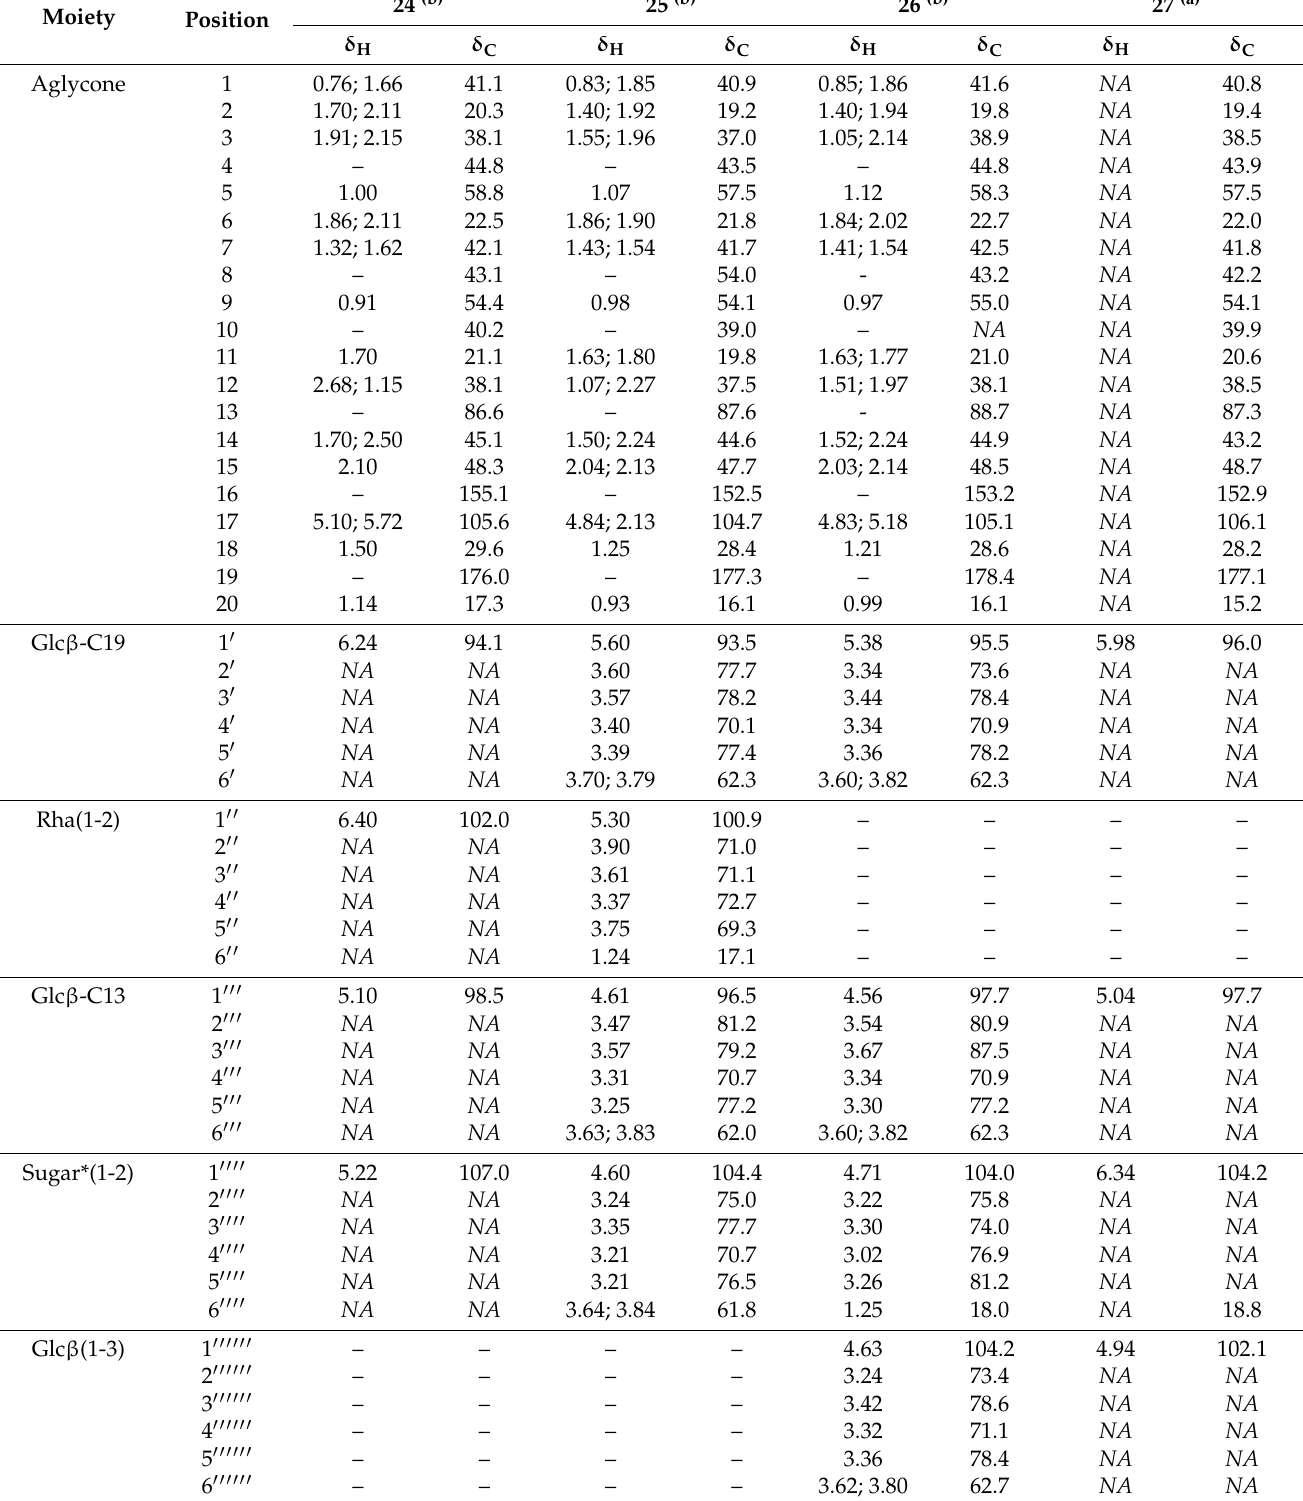
Table 8. 1 H and 13 C chemical shifts of the compounds 24 – 27